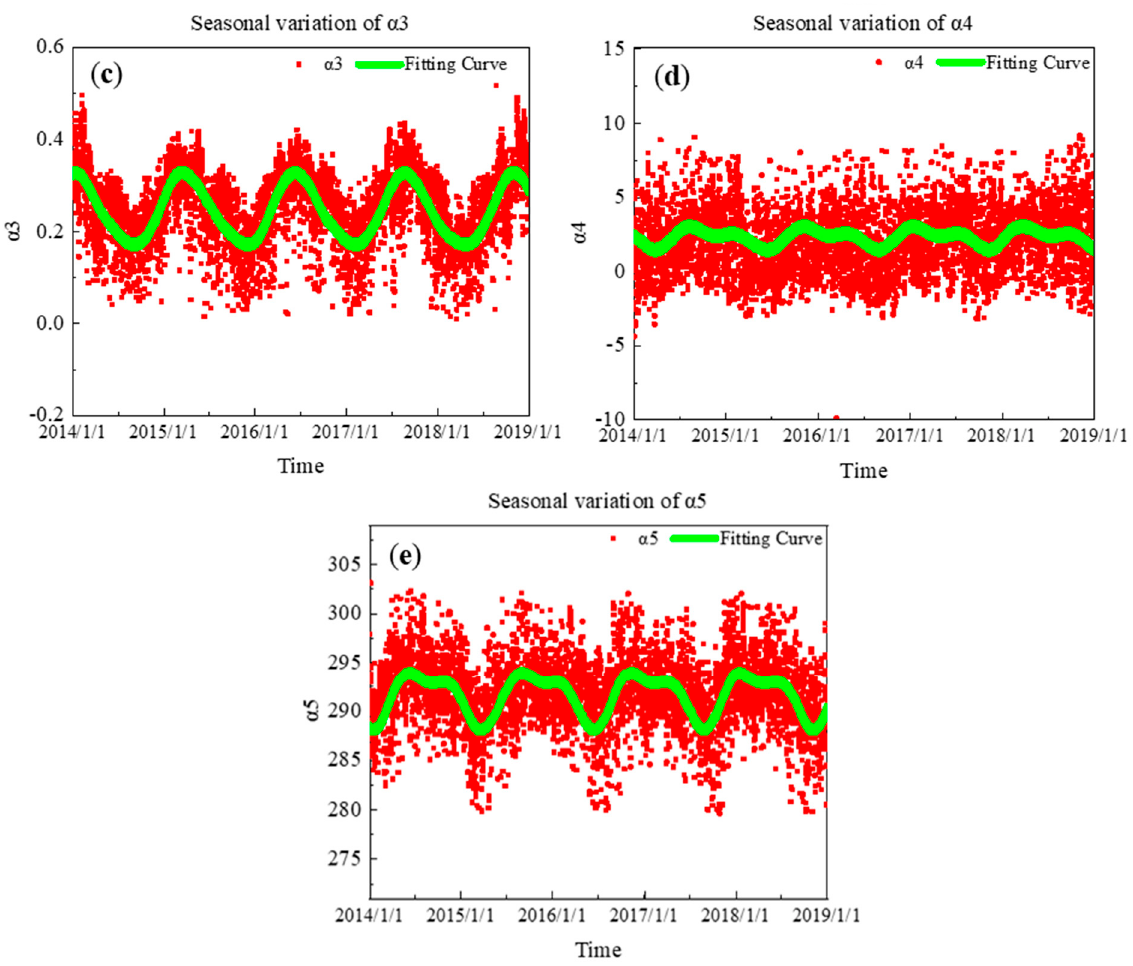
Figure 6. Time series of coefficients of the model with nonlinear elevation correction from 2014 to 2018 ( α 1 ( a ), α 2 ( b ), α 3 ( c ), α 4 ( d ), α 5 ( e )): 55° N, 110° E.